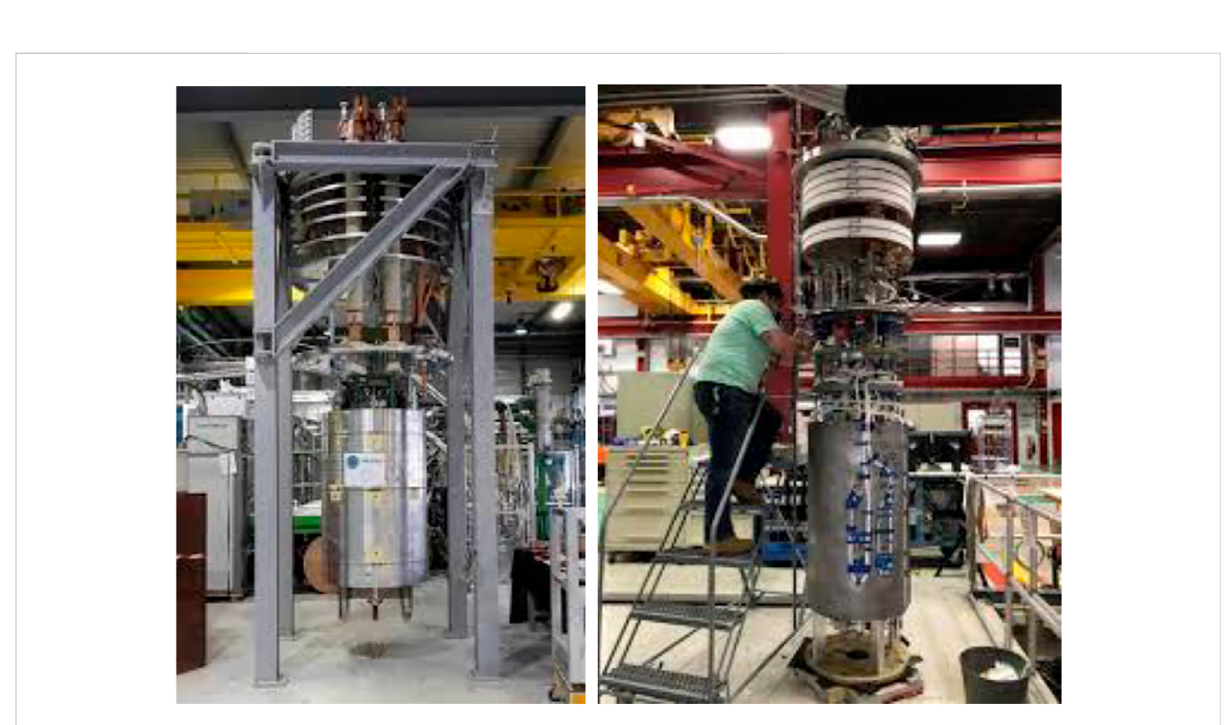
FIGURE 11 The 14.6 T record dipole magnets: 100-mm aperture block-type FRESCA2 (left) and 60-mm aperture cos-theta